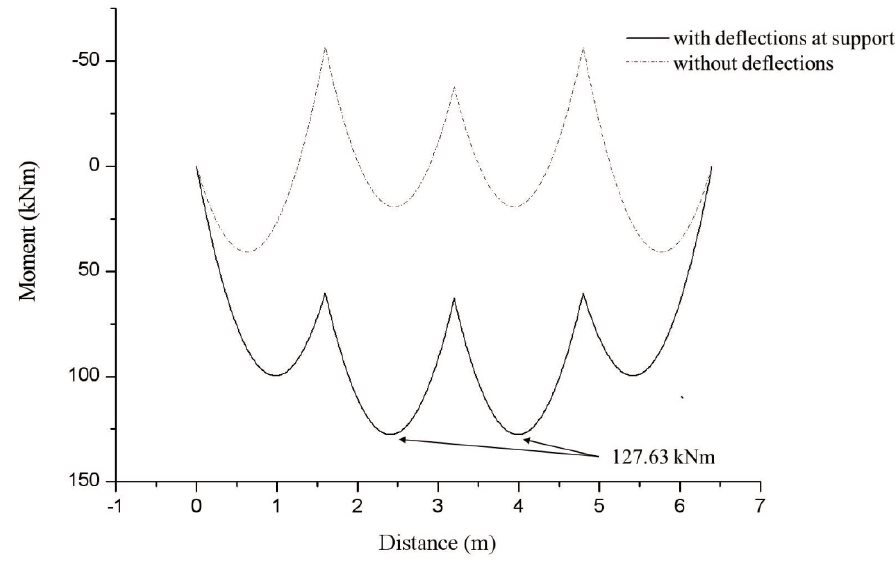
Figure 7. Bending moment diagram for a 4-span beam for estimation of maximum stress.